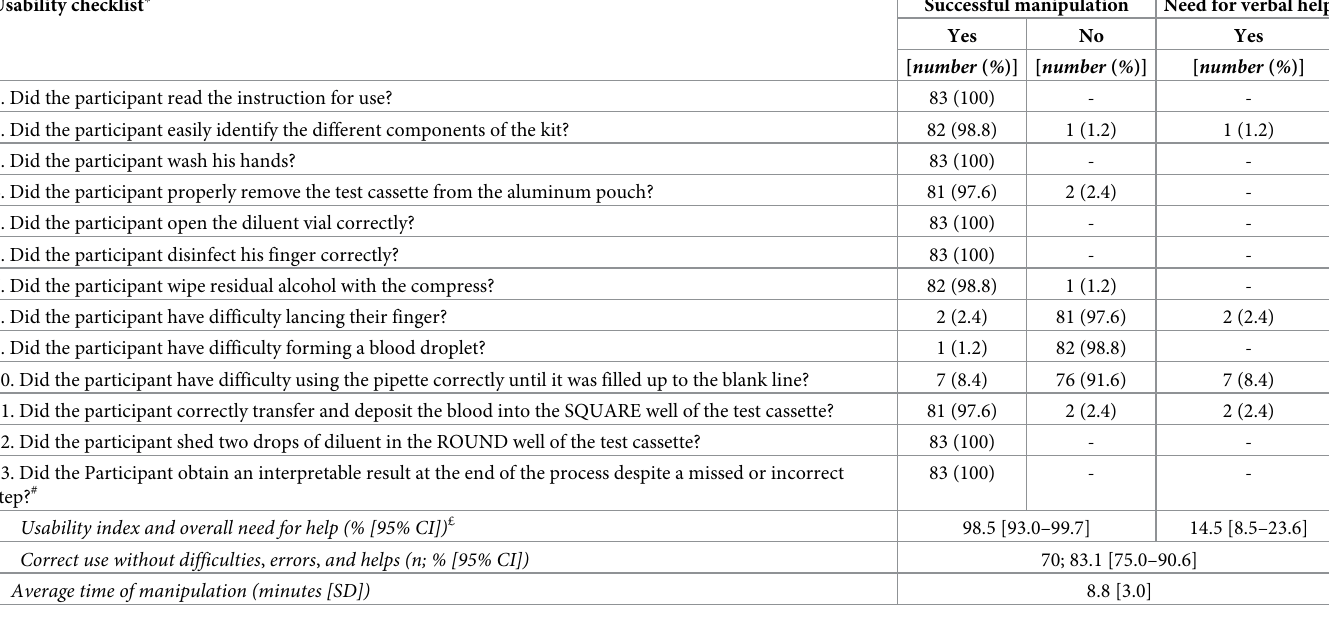
Table 3. Analytical results of the manipulation observation concerning the ability of the randomly selected 83 study participants to correctly use each step of the Exacto 1 COVID-19 self-test (Biosynex Swiss SA) autonomously or with verbal help (substudy 2). Usability checklist